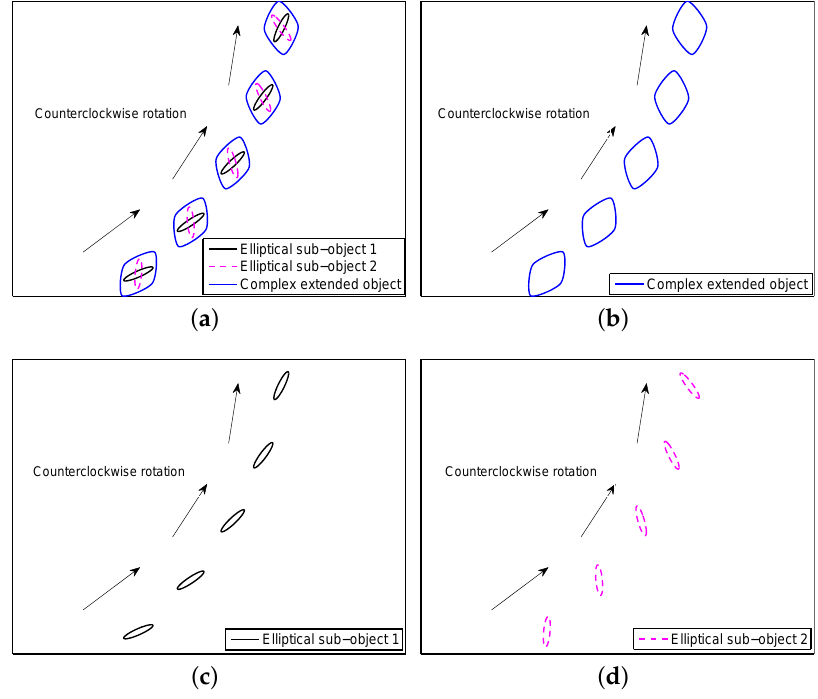
Figure 2. The complex object extension dynamics based on Minkowski sum, ( a ) illustrative example; ( b ) extension dynamics of complex object; ( c ) extension dynamics of sub-object 1; ( d ) extension dynamics of sub-object